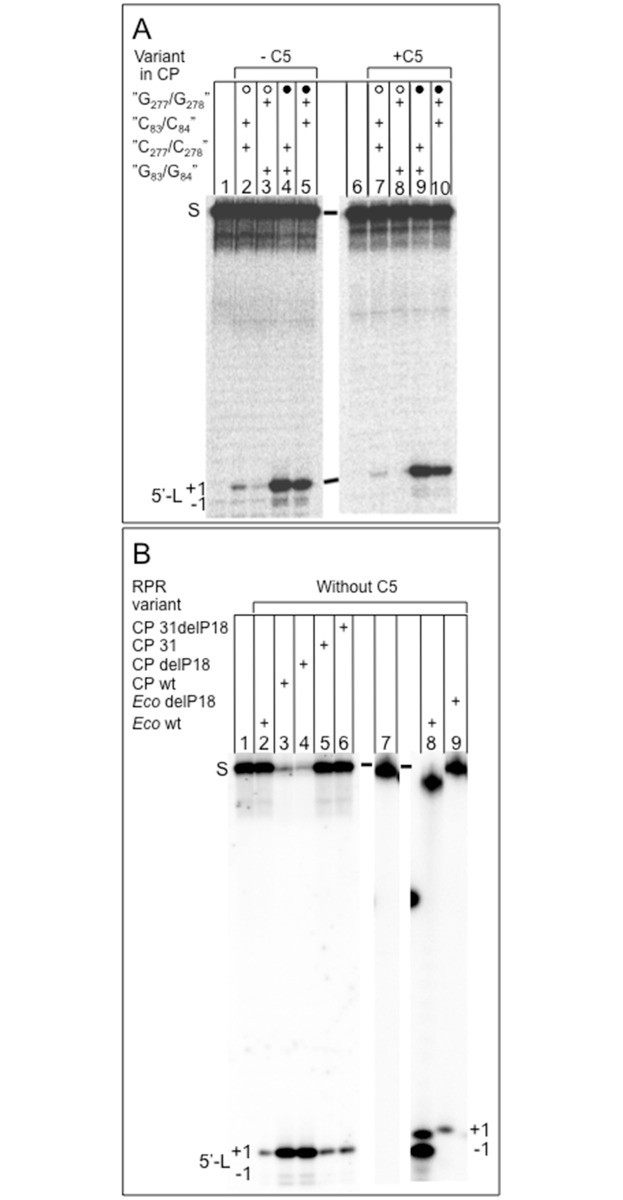
Cleavage of the model hairpin loop substrate pATSerUG.A. Cleavage with different Eco CP RPR carrying changes that affect the "P6-mimic" (Fig 2A). The experiments were done with and without the C5 protein as indicated. Reactions without the C5 protein were performed in buffer C and 800 mM Mg2+ (cf. lanes 1 to 5) while those with the protein were done in buffer A and 10 mM Mg2+ (cf. lanes 6 to 10). All the reactions were done at 37°C and black and open circles as defined above. The concentrations of the RPRs were 0.7 nM with C5 and 2.7 μM without. The concentration of the C5 protein was 0.76 μM (empirically determined) and ≤0.02 μM for pATSerUG. Incubations were 30 min in all cases. Lane 1, pATSerUG alone; lane 2, Eco CP RPRC83C84; lane 3, Eco CP RPRG277G278; lane 4, Eco RPRwt; lane 5, Eco CP RPRC83C84/G277G278; lane 6, pATSerUG alone; lane 7, Eco CP RPRC83C84; lane 8, Eco CP RPRG277G278; lane 9, Eco RPRwt; lane 10, Eco CP RPRC83C84/G277G278. S = pATSerUG, 5'-L = 5' cleavage fragments and +1 and -1 marks were cleavage had occurred (see Fig 5 and text for details). B. Cleavage with various Eco RPR and CP RPR variants as indicated. The concentration of pATSerUG was ≤0.02 μM while the concentrations of the RPR varied: Eco CP RPRwt 8.2 μM (lane 3), Eco CP RPRdelP18 9.2 μM (lane 4), Eco CP RPR31 9.0 μM (lane 5), Eco CP RPR31delP18 10.2 μM (lane 6), and Eco RPRdelP18 3.2 μM (lane 9). The reaction times were 20 min for Eco CP RPRwt and Eco CP RPRdelP18, 60 min for Eco CP RPR31, Eco CP RPR31delP18 and Eco RPRdelP18. Controls, incubation of pATSerUG alone without RPR (lane 1), cleavage of pATSerUG (lane 2) and pATSerCGGAAA (known to cleave at +1 and -1, see 18 Wu et al. 2011; lane 8) with Eco RPRwt. S = substrate, 5'-L = 5' cleavage fragments and +1 and -1 marks cleavage sites (see text for details).